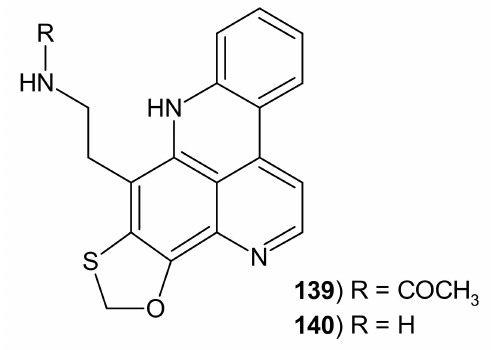
Figure 37. Lissoclinidines 139 – 140